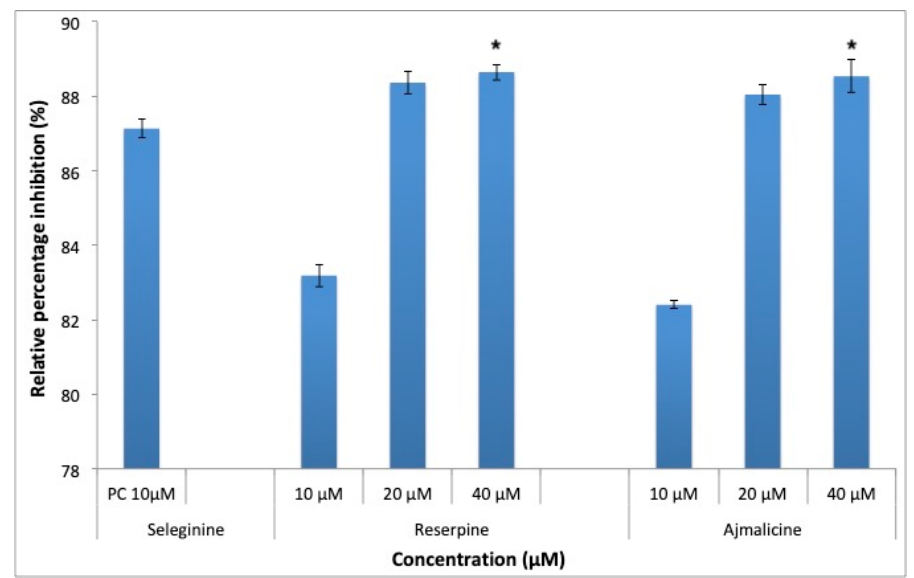
Figure 13. Monoamine oxidase-B (MAO-B) inhibition by positive control (selegiline) at 10 μ M, RES and AJM at 10, 20 and 40 μ M concentration; values represents mean ± SEM, n = 3; and * difference in mean is statistically very significant p < 0.001 as compared to control group.